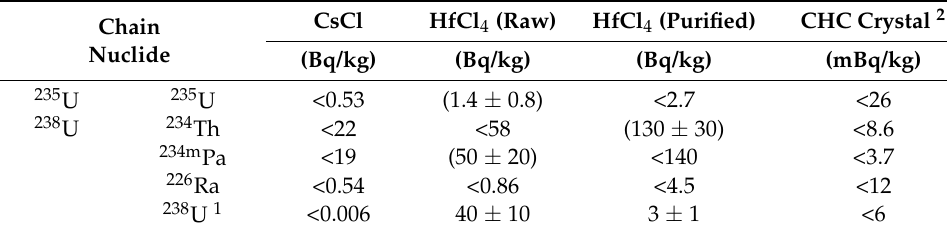
Table 3. Activities measured by γ -ray spectrometry and ICP-MS. CsCl HfCl 4 Chain Nuclide